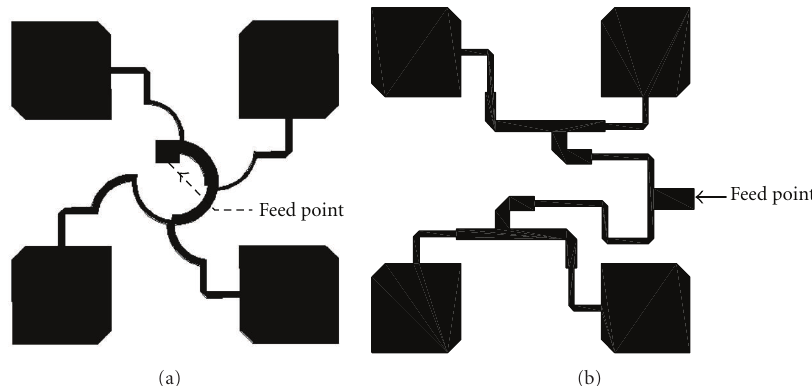
Figure 2: 4-element CP antenna arrays; (a) with the single series-parallel sequential rotation feeding network; (b) with the conventional parallel feeding network.